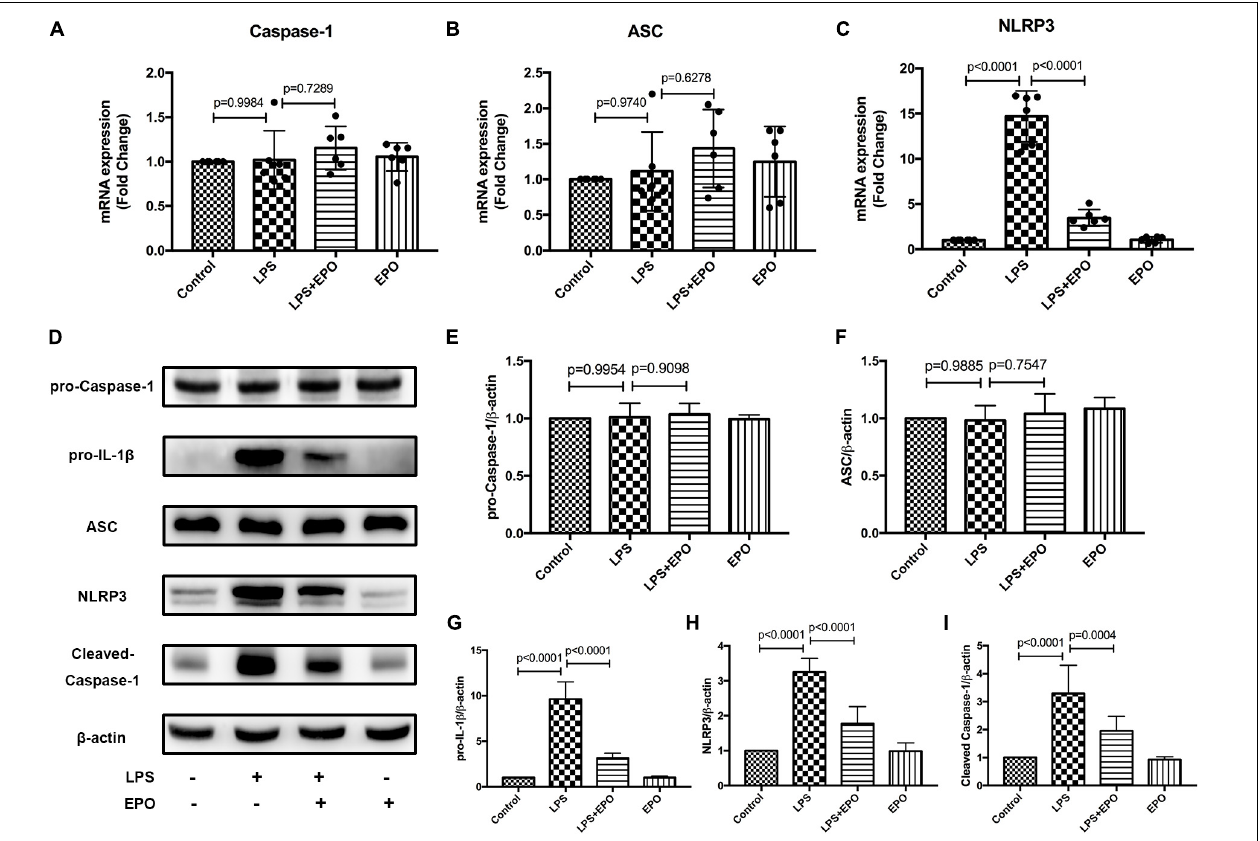
FIGURE 3 | EPO suppressed the NLRP3 inflammasome in LPS-induced ALI. EPO (5 U/g) was injected into the peritoneal cavity of mice after LPS (15 mg/kg) stimulation. The mice were sacrificed 8 h later, and the lung tissues were obtained to measure the mRNA expression levels of caspase-1, ASC, and NLRP3 (A–C) by QPCR. In addition, the protein expression levels of pro-caspase-1, pro-IL-1 β , ASC, NLRP3, and cleaved caspase-1 (D–I) were detected by Western blotting. The data are presented as the mean ± SD. The differences among groups were assessed by one-way ANOVA and the post hoc test (Turkey method) was applied to investigate the differences one by one. n = 8 per